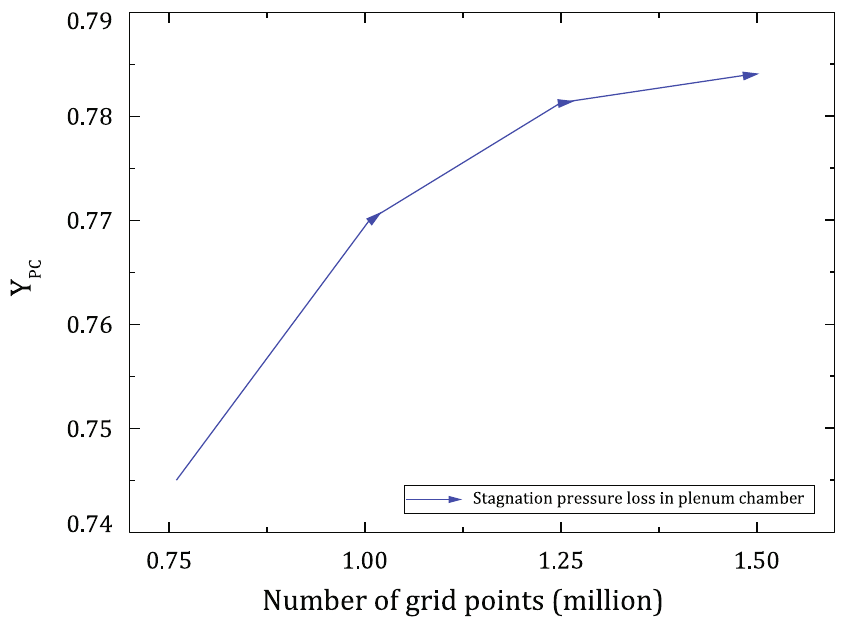
Figure 6: Coe ffi cient of stagnation pressure loss (SPL) in plenum chamber for di ff erent numbers of grid points.